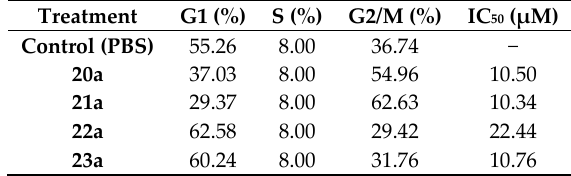
Table 2. Cell cycle distribution of ovarian carcinoma OVCR-3 with different treatments.